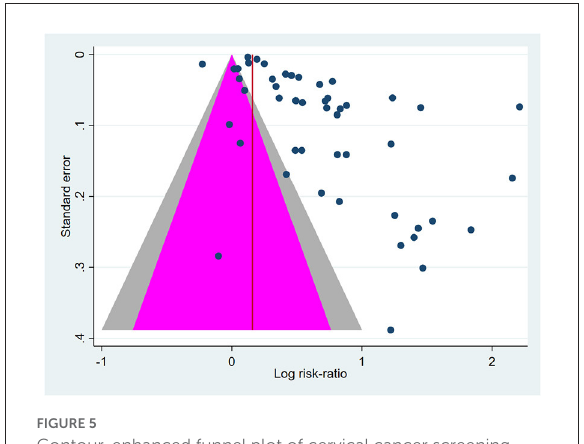
FIGURE5 Contour-enhanced funnel plot of cervical cancer screening (CCS) uptake effect size (log odds-ratio) vs. Standard error. Outcome: screening uptake. Pink-area: p > 0.05. Gray area: 0.01 < p < 0.05. Blue dots represent single studies. Peters’ test for publication bias: p = 0.060.